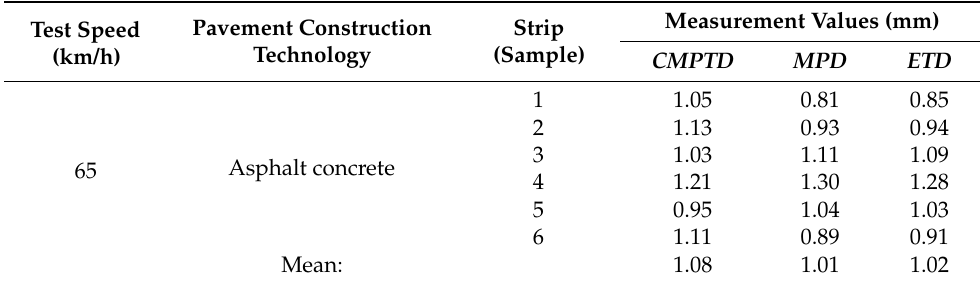
Table 12. Field tests results for asphalt concrete (65 km/h).